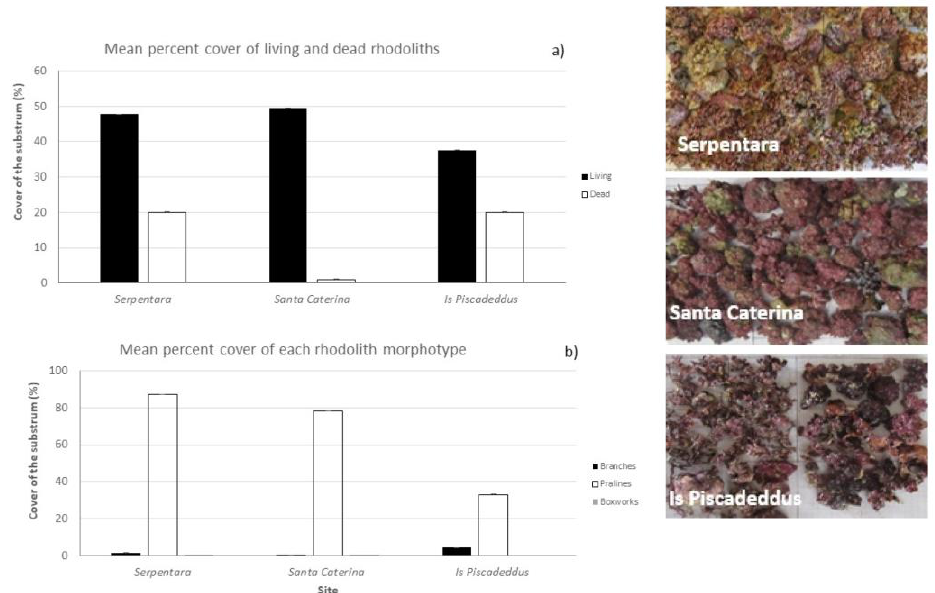
Figure 4. Mean (±SE) percent cover of the substratum by rhodoliths in relation to their health status ( a ) and morphotypes ( b ) in each of the three transects considered for the three sites. On the right, an example of a rhodolith sample for each site is shown, with the different morphotypes clearly visible. Table 1. Results of ANOVA and SNK were used to test for significant differences in rhodoliths’ percent cover of the substratum in the three investigated sites (Sc = Santa Caterina; Se = Serpentara; IP = Is Piscadeddus) in relation to their health status (L = living; D = dead) and present morphotypes (Br = branches; Bw = boxwork; Pr = pralines). Significant results are given in bold. Moreover, the SNK test for the significant interactions between Site × Health Status and Site × Morphotype is also presented. ANOVA (a) Health Status